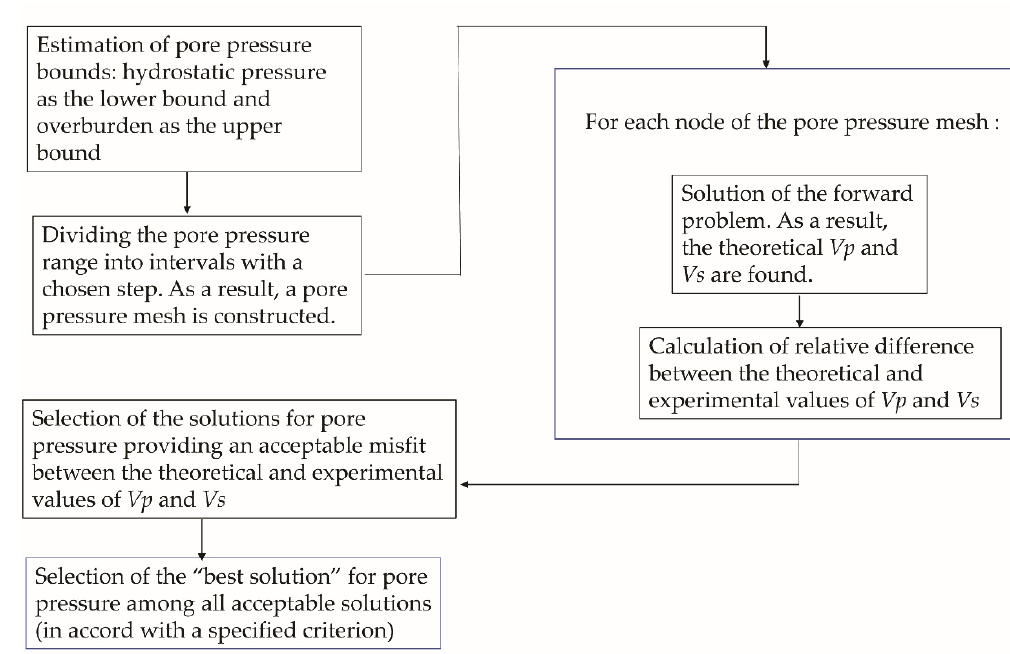
Figure A3. Flowchart for the determination of the pore pressure from seismic data.